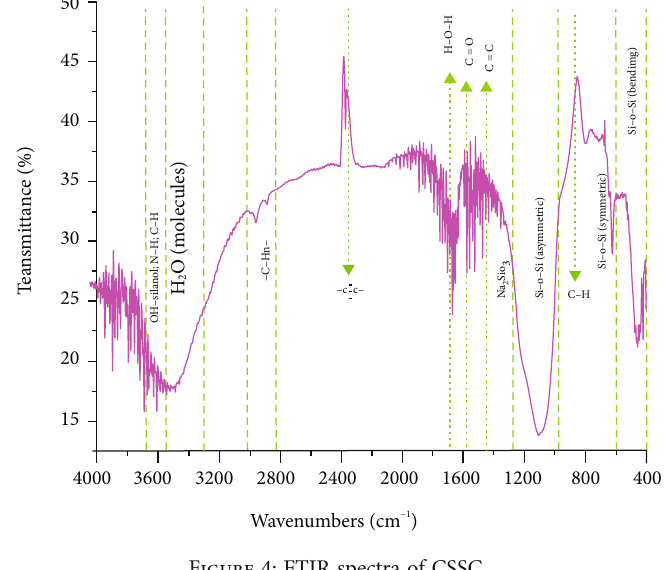
Figure 4: FTIR spectra of CSSC.